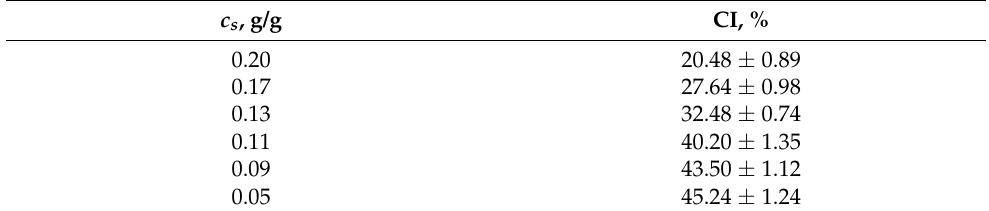
Table 1. The CI (%) values in the investigated starch–fat emulsions at different starch concentrations (g/g) in systems. The values are expressed as means ± SD ( n = 3). c s , g/g CI, % 0.20